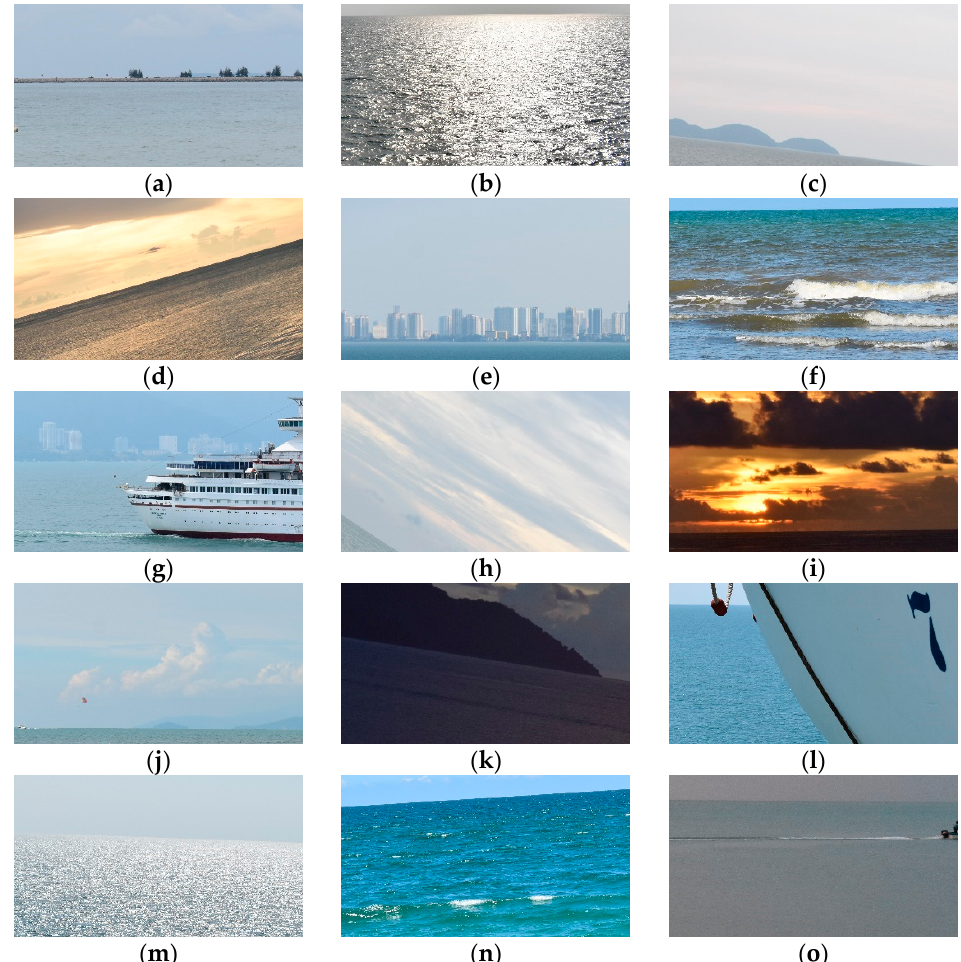
Figure 6. Sample images from MU-SID; ( a – o ) features such as different level of illumination, sky conditions, strong glint and glare, foreground and background objects, false linear features, sea states, partial occlusion, haze, variation in SHL angle and position in different cross-sections of images are visible.